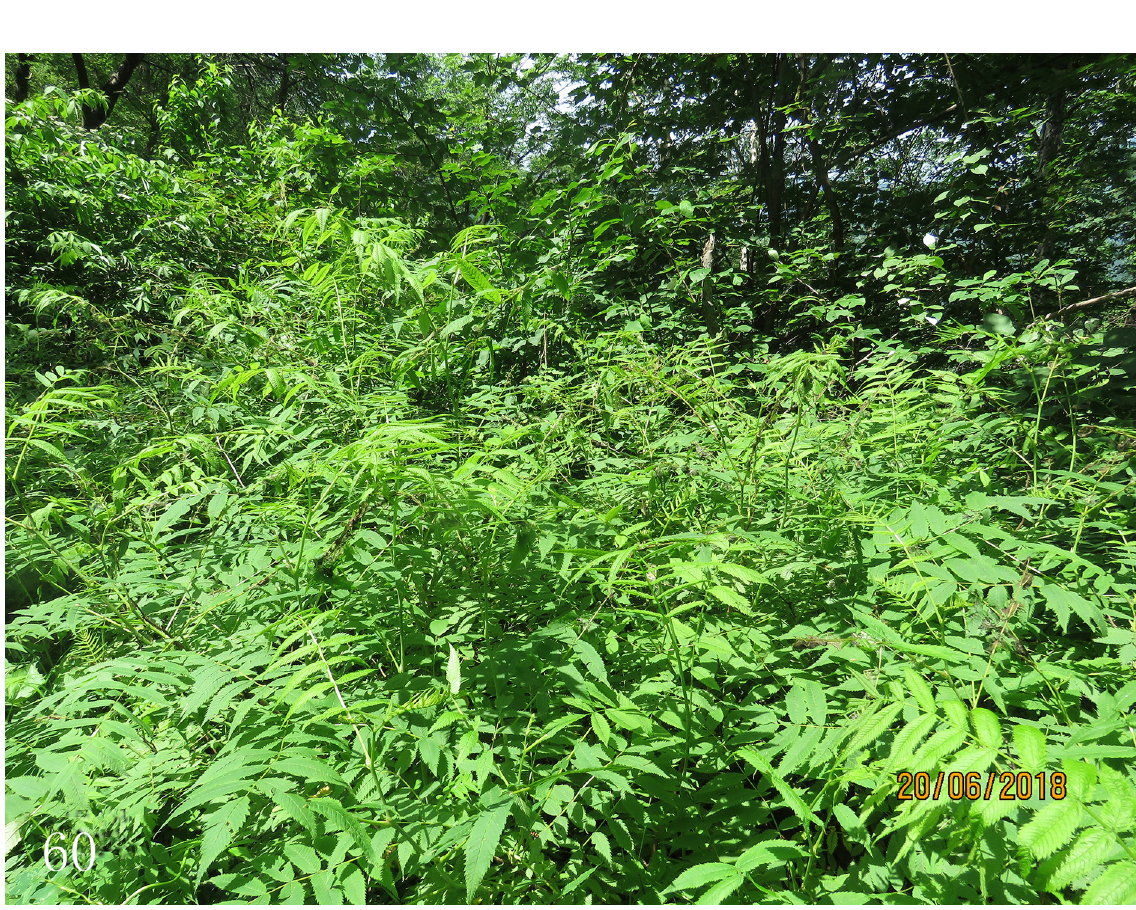
Fig. 60. Habitat of Ctenopelma tomentosum (Desvignes, 1856): the shrub, Sorbaria sorbifolia (L.) A.Braun, in Benxi, Laoning Province,